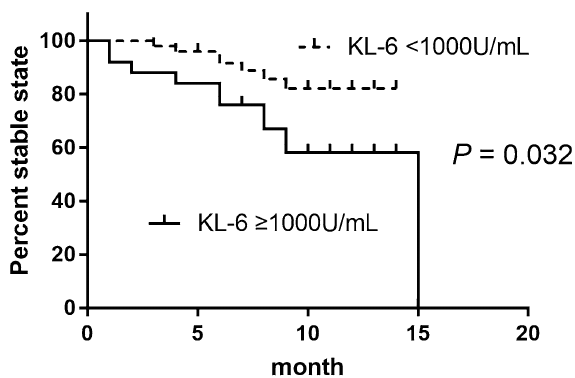
Figure 2. Disease progression according to the baseline KL-6 level groups. KL-6: Krebs von den Lungen-6.